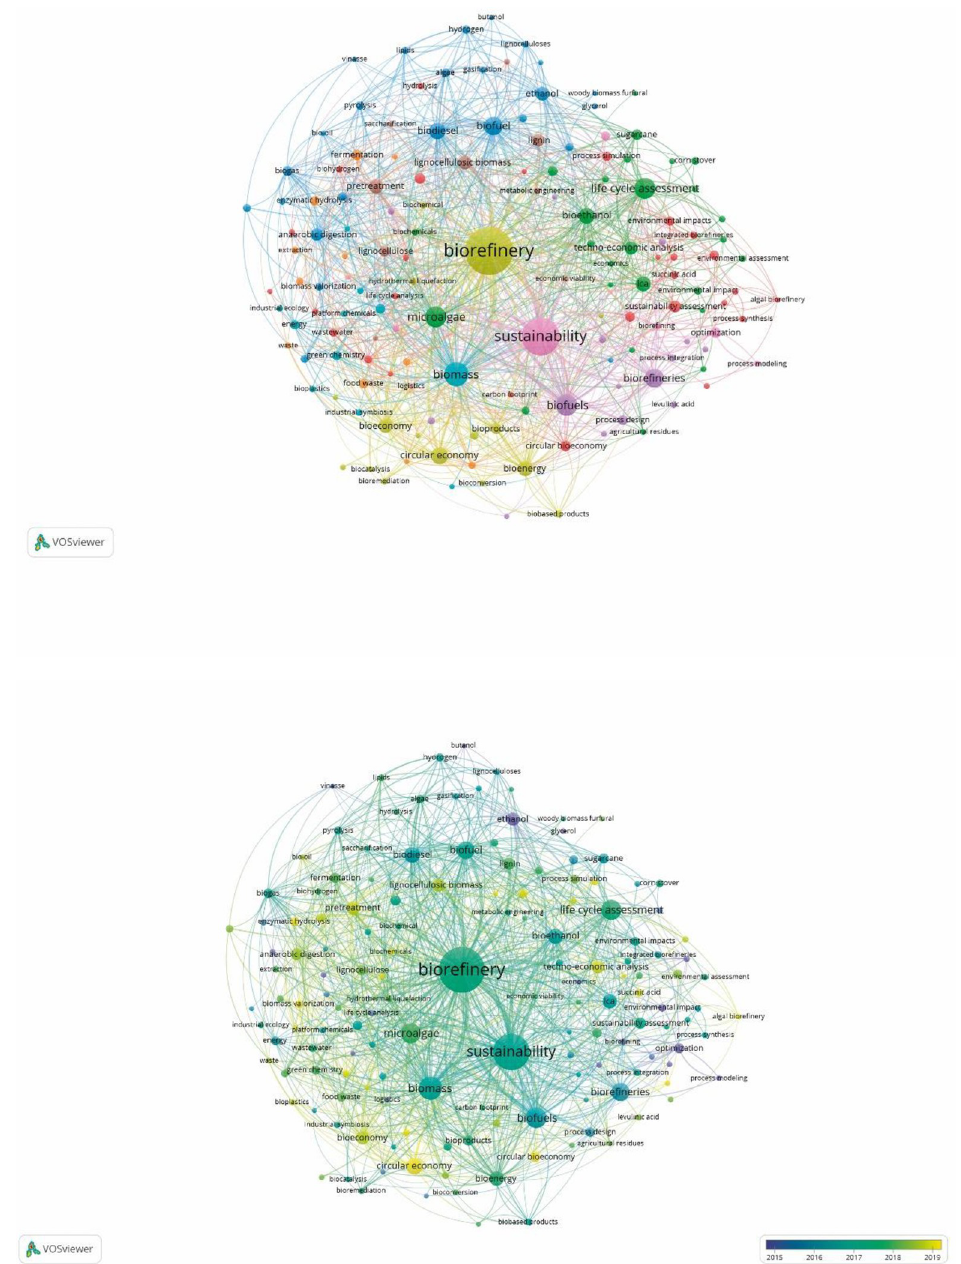
Fig 3. Co-occurrence analysis—keywords (author). Source: Authors’ elaboration based on Scopus [29,